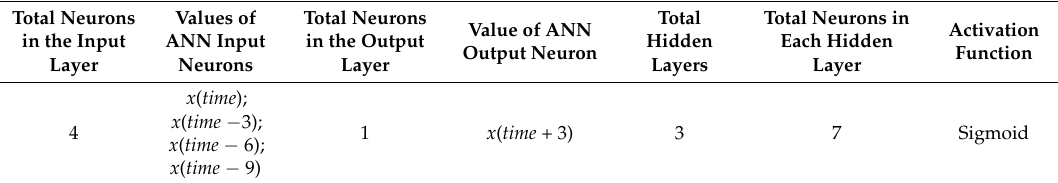
Table 3. Adjustments of ANN models employed in prediction applications for the EEG time series (Figure 5) in the study.